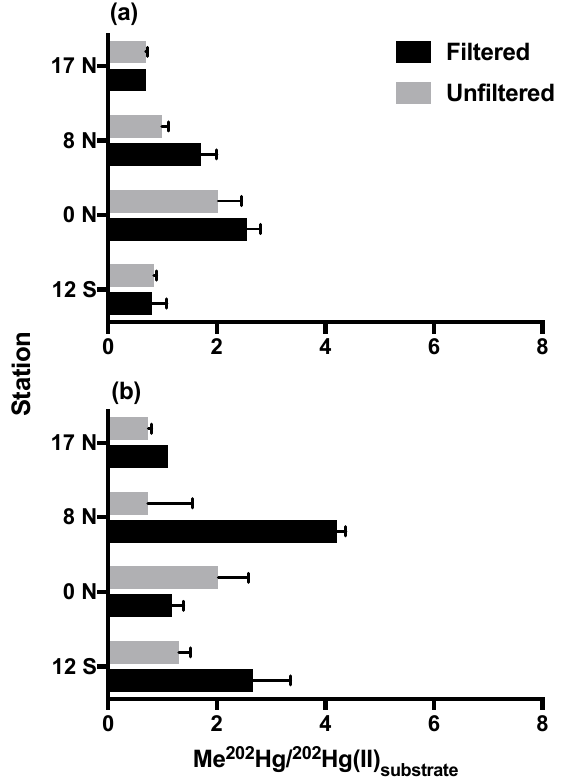
Figure 1. Methylation of Hg(II) in tropical Pacific waters from trip- licate bottle incubation ( ± 1 SD), as the percentage of Me 202 Hg produced from excess 202 Hg ( II ) substrate from isotope spike ad- ditions, for cruise stations from the North to South Pacific. Methy- lation was measured in 0.2µm filtered and unfiltered waters from the chlorophyll-maximum (a) and oxygen-minimum (b) depths at each